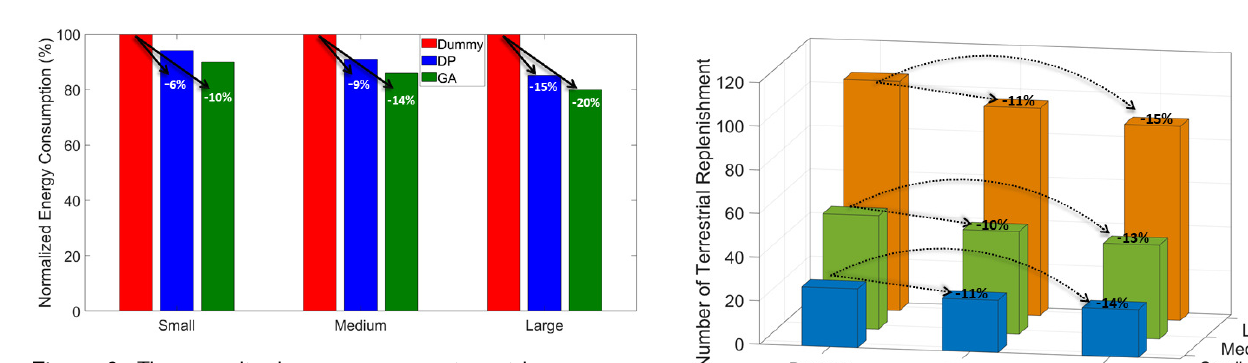
energy consumption, less number of terrestrial replen- ishment, and more average endurance per ABS are obtained by applying the flight path planning